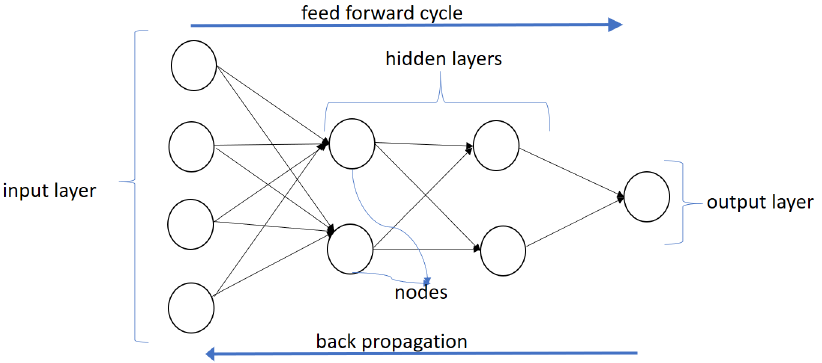
Figure 1. A simple neural network with two hidden layers of two nodes each, four inputs, and a single output